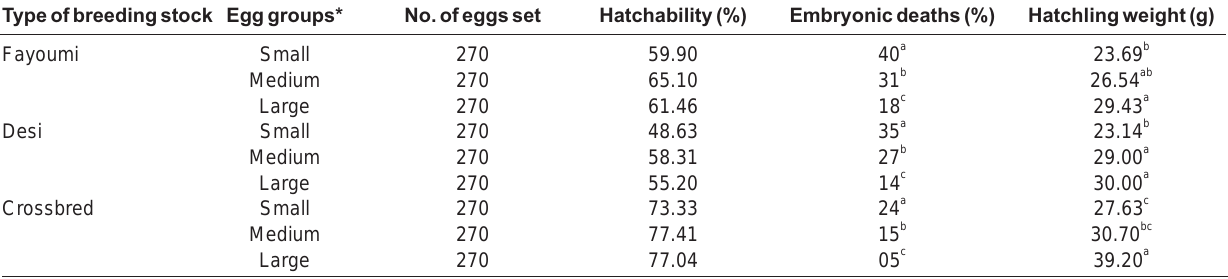
Table-1. Effect of egg weight on hatchability, embryonic deaths and hatchling weight in Fayoumi, Desi and crossbred (RIR X Fayoumi) chickens Type of breeding stock Egg groups*